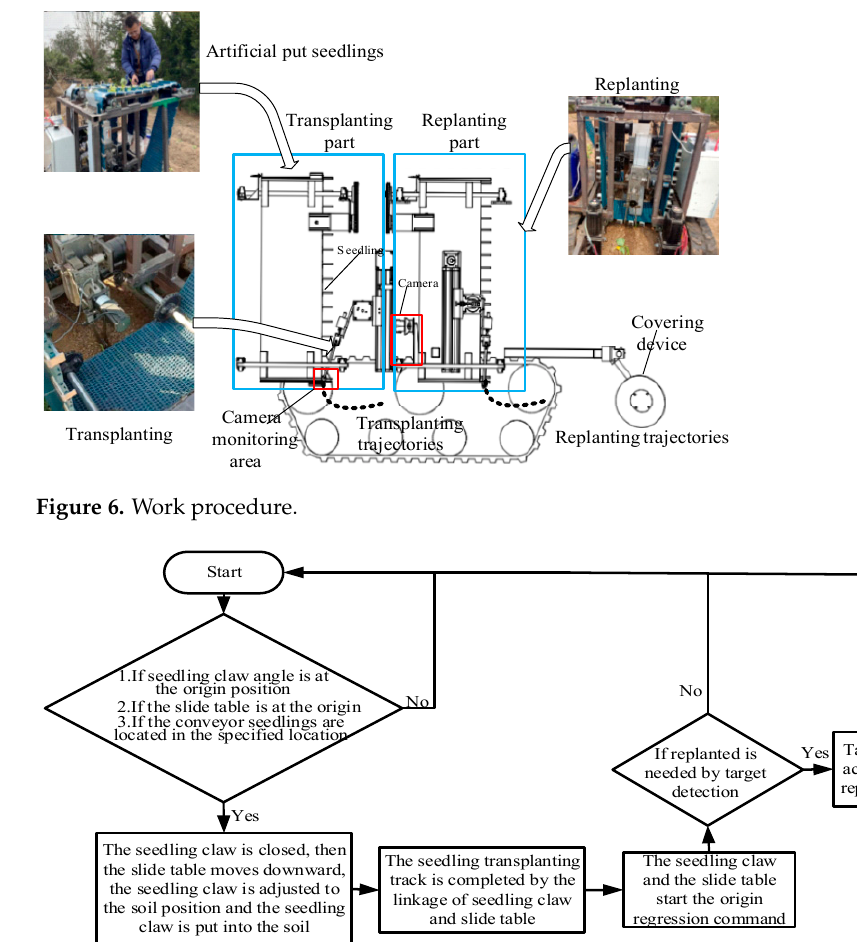
Figure 7. Work procedure flow chart.